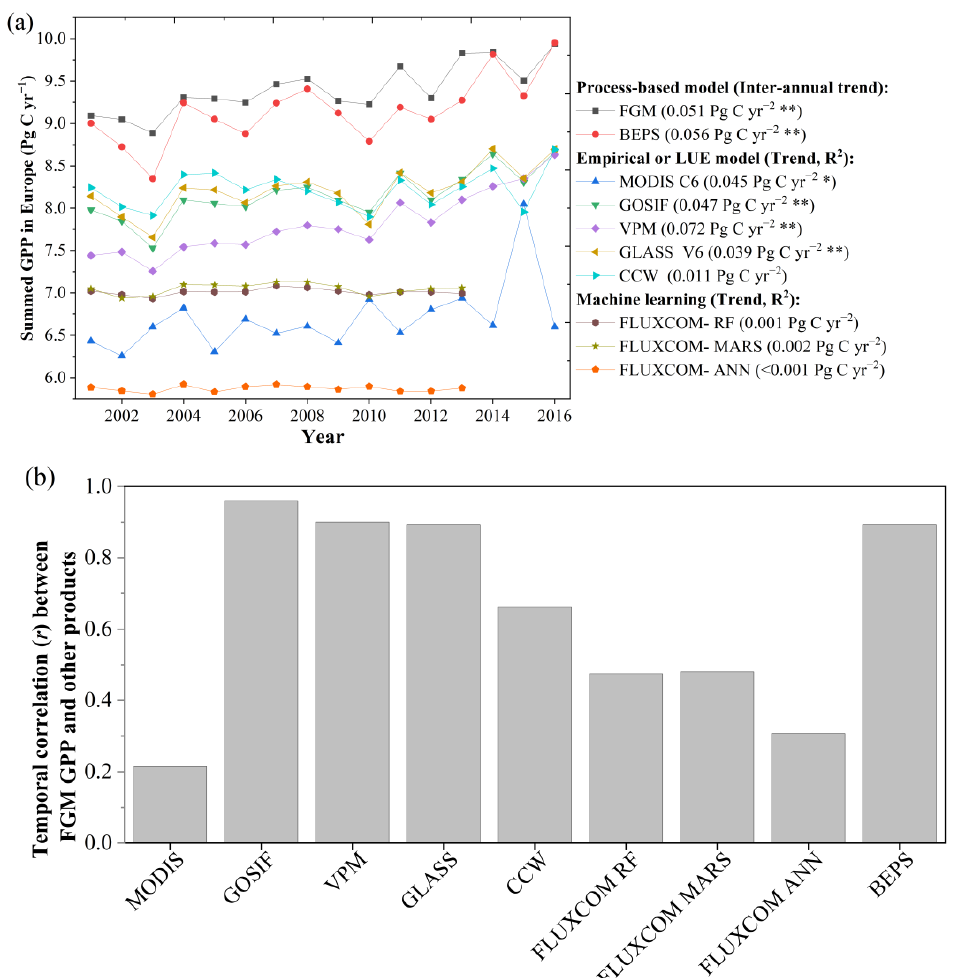
Figure 6. Comparison of the interannual variations in annual GPP (Pg C yr −1 ) simulated by the FGM and by other methods (including BEPS, MODIS, CCW, GLASS, VPM, GOSIF, FLUXCOM-RF, FLUXCOM-MARS, and FLUXCOM-ANN). ( a ) Interannual dynamics of annual GPP for Europe during 2001 – 2016. ** and * indicate increasing trends in the total annual GPP from 2001 to 2016 at p - value < 0.05 and p -value < 0.01, respectively. ( b ) Temporal correlation (r) between the FGM GPP and other GPP products. A total of nine global GPP products were estimated by different methods.